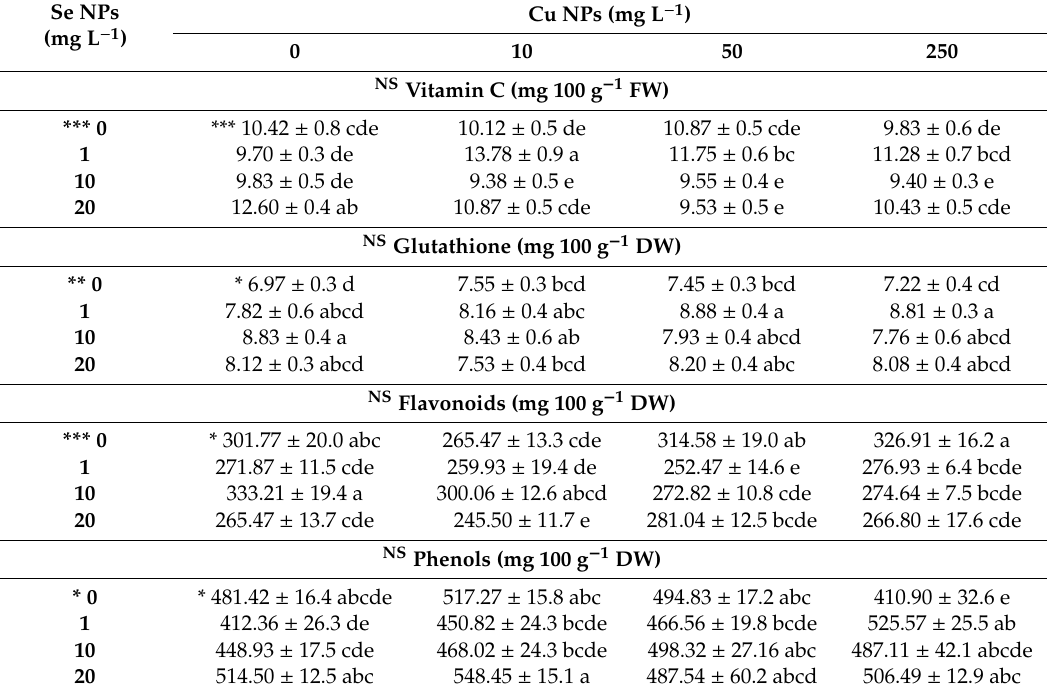
Table 3. Non-enzymatic antioxidant compounds in tomato leaves from plants treated with Se and Cu NPs.